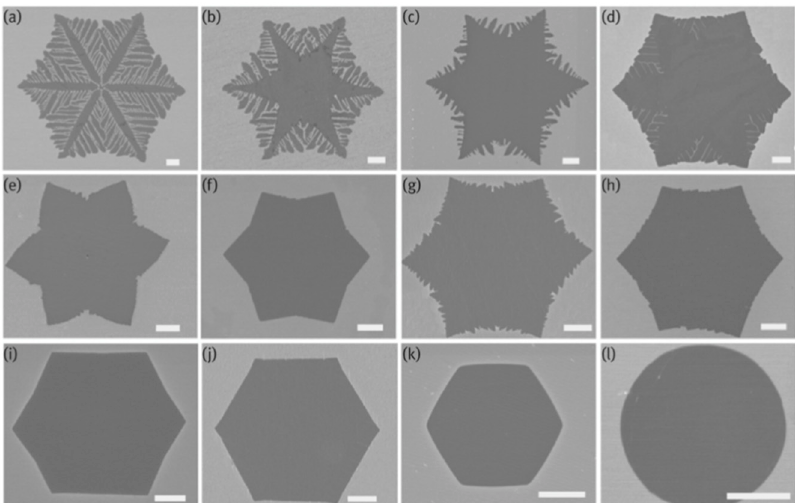
Figure 4. SEM images illustrate the evolution of the shape of graphene domains using di ff erent H 2 / CH 4 ratios. ( a – h ), H 2 / CH 4 ratios are 20, 30, 40, 60, 70, 80, 100 and 120, respectively, while the CH 4 flow rate is kept constant at 0.5 sccm. The flow rates of H 2 / CH 4 for ( i – l ) are 200 / 2, 200 / 4, 300 / 5 and 300 / 22 sccm, respectively. All scale bars are 5 µ m (reprinted with permission from [63]).